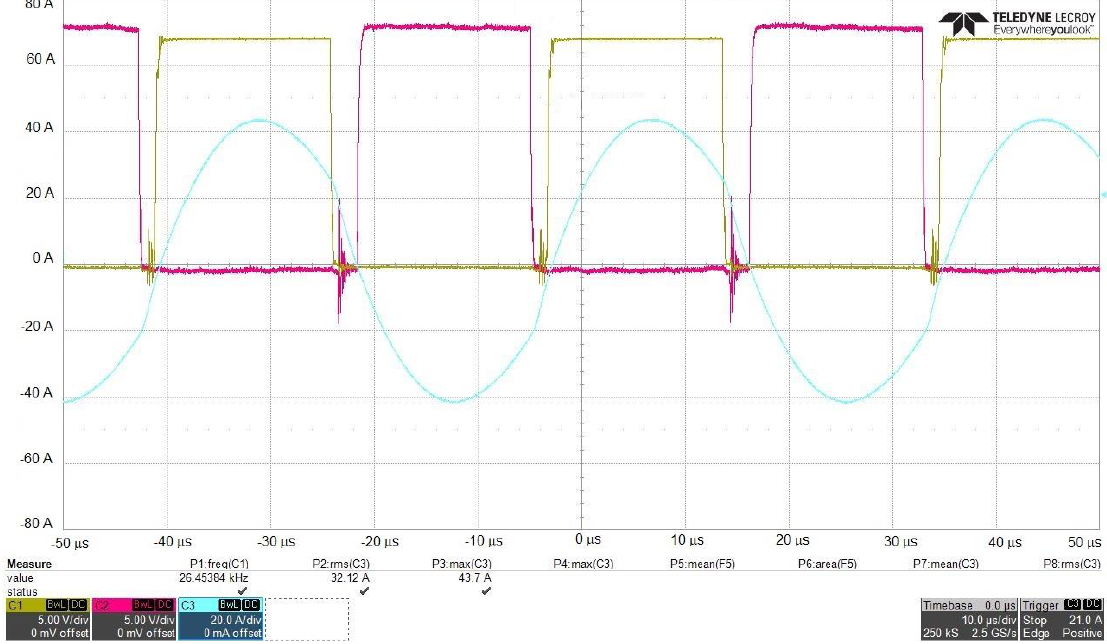
Figure 35. High-side IGBT control signal (C1, green), low-side IGBT control signal (C2, purple), and transmitter coil current (C3, blue) at 26 kHz.